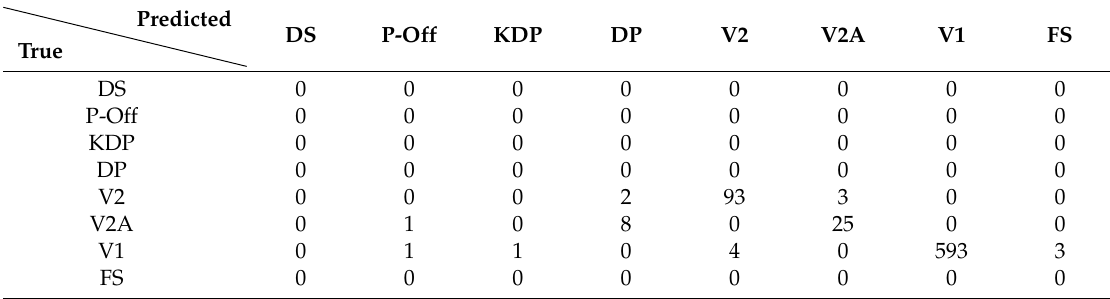
Table A2. Confusion matrix for the natural course, skating style validation set of skier 2 when using the sports biomechanics configuration of sensors.